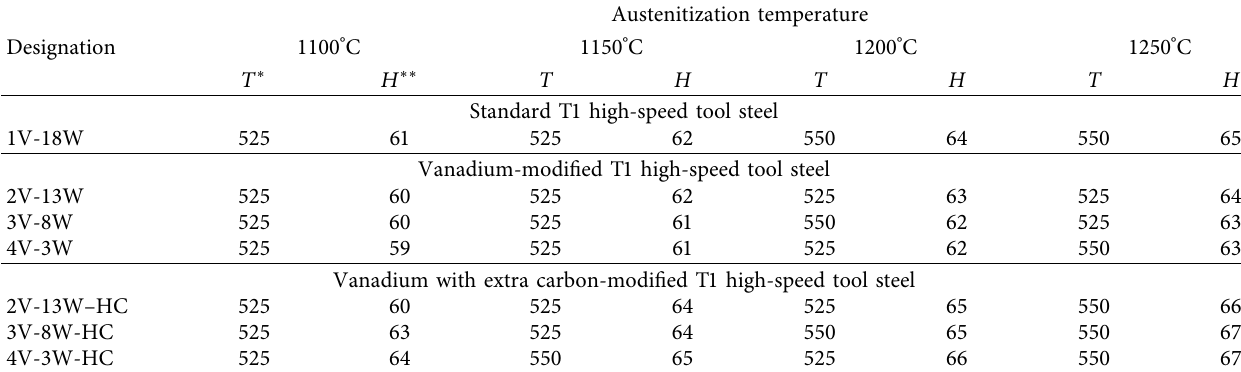
Table 9: Secondary hardening temperature and hardness values of investigating